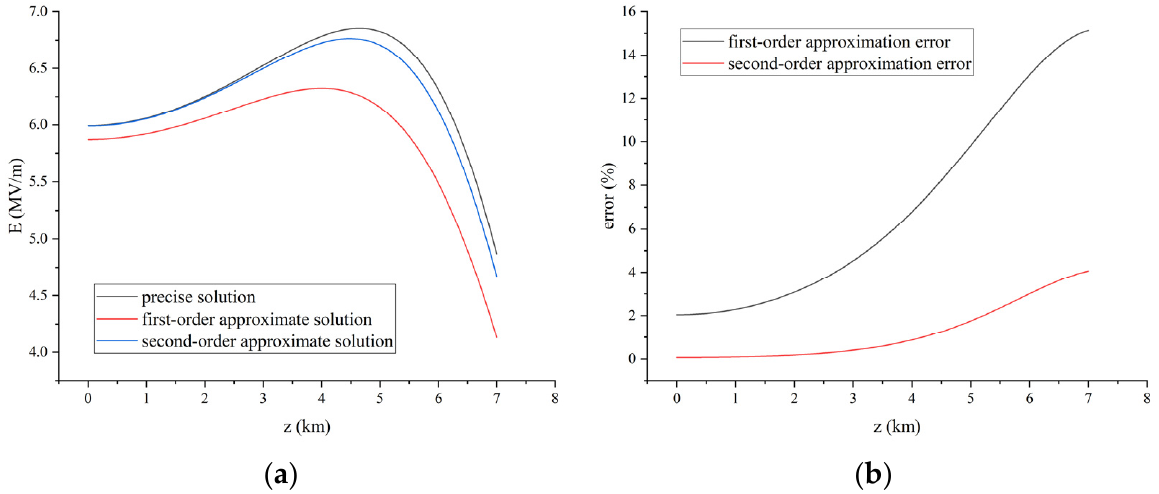
Figure 5. ( a ) Comparison of the first-order approximate solution, second-order approximate solution